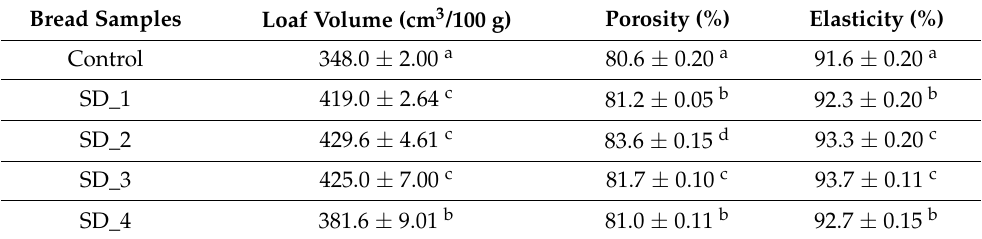
Table 5. Physical characteristics of the bread samples with different levels of dry sourdough (SD) addition. Bread Samples Loaf Volume (cm 3 /100 g) Porosity (%) Elasticity (%)